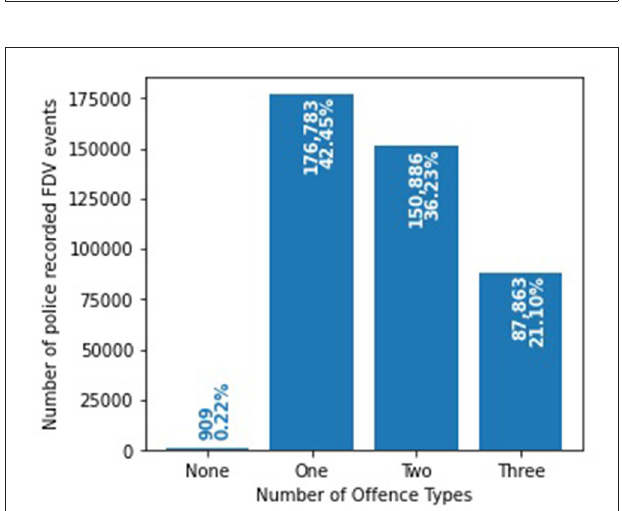
FIGURE 2 | Distribution and intersection of the three offense types within the 416,441 police recorded FDV events.